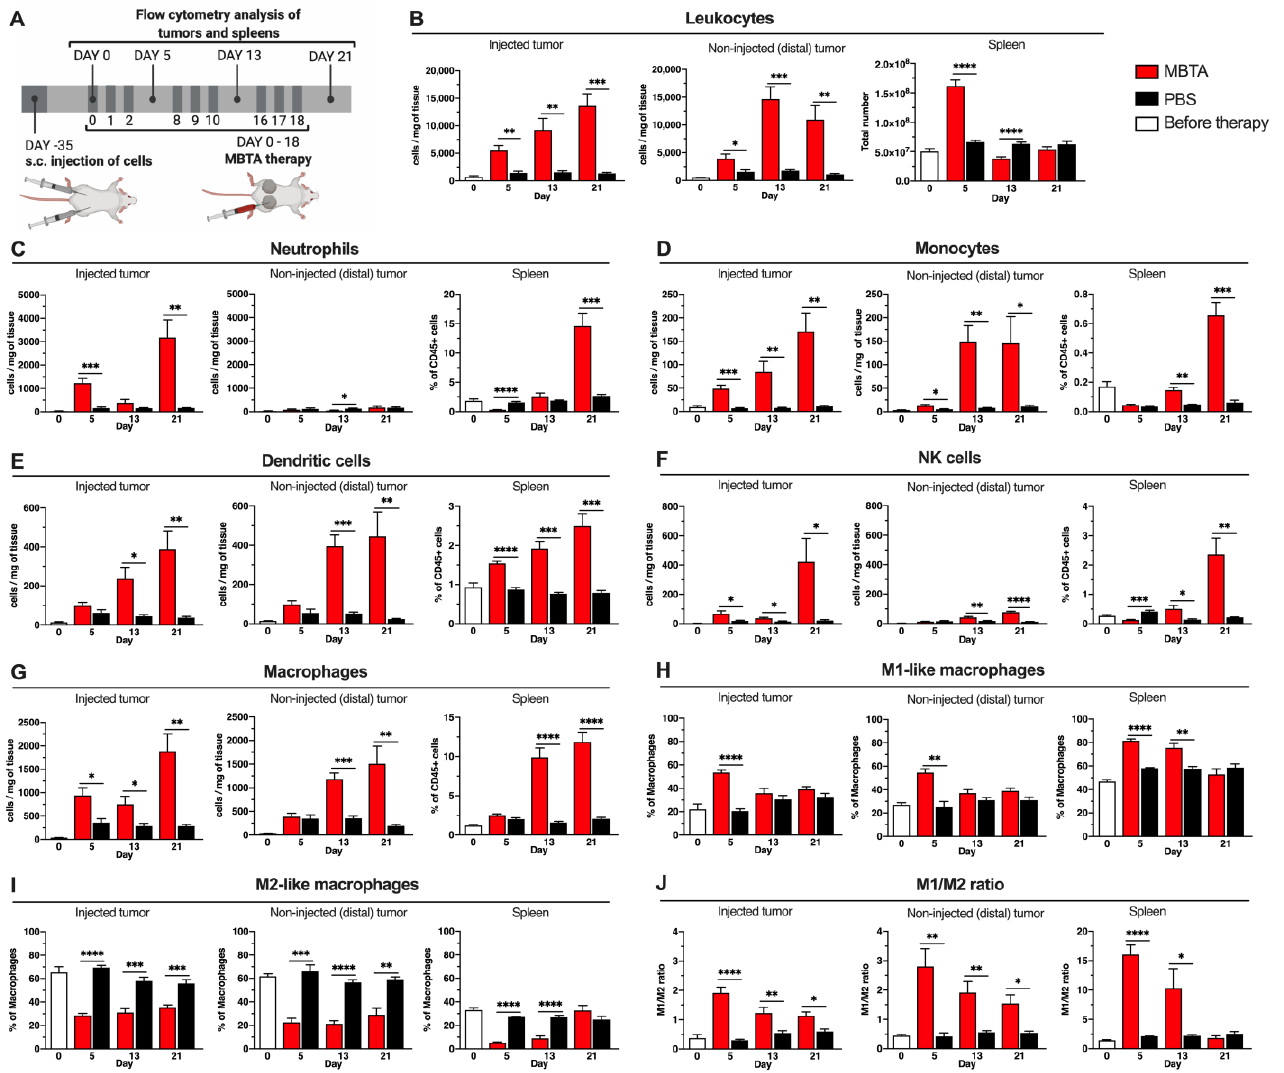
Figure 2. Flow cytometry analysis of tumor infiltrating leukocytes and innate immune cells. ( A ) Experimental design dia- gram of the flow cytometry analysis. The results from the analysis of injected and distal tumors and spleens: ( B ) leukocytes (CD45 + ), ( C ) neutrophils (CD45 + CD11b + F4/80 − Ly6G + Ly6C lo ), ( D ) monocytes (CD45 + CD11b + F4/80 − Ly6G − Ly6C hi ), ( E ) DCs (CD45 + CD11b − F4/80 − CD11c + ), ( F ) NK cells (CD45 + CD3 + CD335 + ), ( G ) Macrophages (CD45 + CD11b + F4/80 + ), ( H ) M1-like macrophages (CD45 + CD11b + F4/80 + CD279 − CD38 hi ), ( I ) M2-like macrophages (CD45 + CD11b + F4/80 + CD279 +/ − CD38 lo ), ( J ) M1/M2 ratio (n = 5 per group/day) (* p < 0.05, ** p < 0.01, *** p < 0.001, **** p < 0.0001).